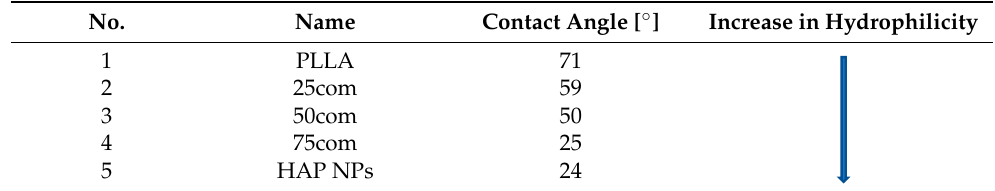
Table 2. Contact angle of PLLA and HAP NPs samples, and composite samples obtained by two ‐ stage forming.